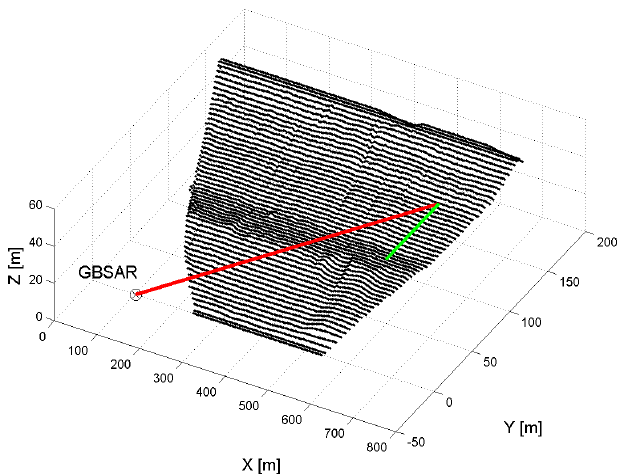
Figure 1. Geometry for the rendering of GBSAR displacement maps over a Digital Elevation Model (DEM). The range and displacement vectors are shown in red and green, respectively.